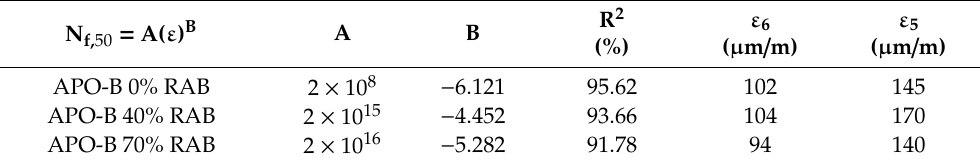
Figure 5. Fatigue curves (Nf50) of the three asphalt mixtures. Table 5. Fatigue test parameters for the asphalt mixtures.